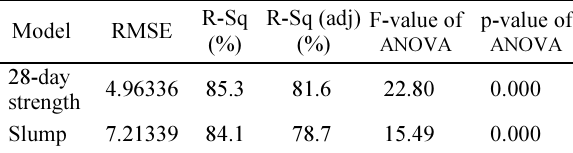
Table 4. Summary statistics of strength and slump models